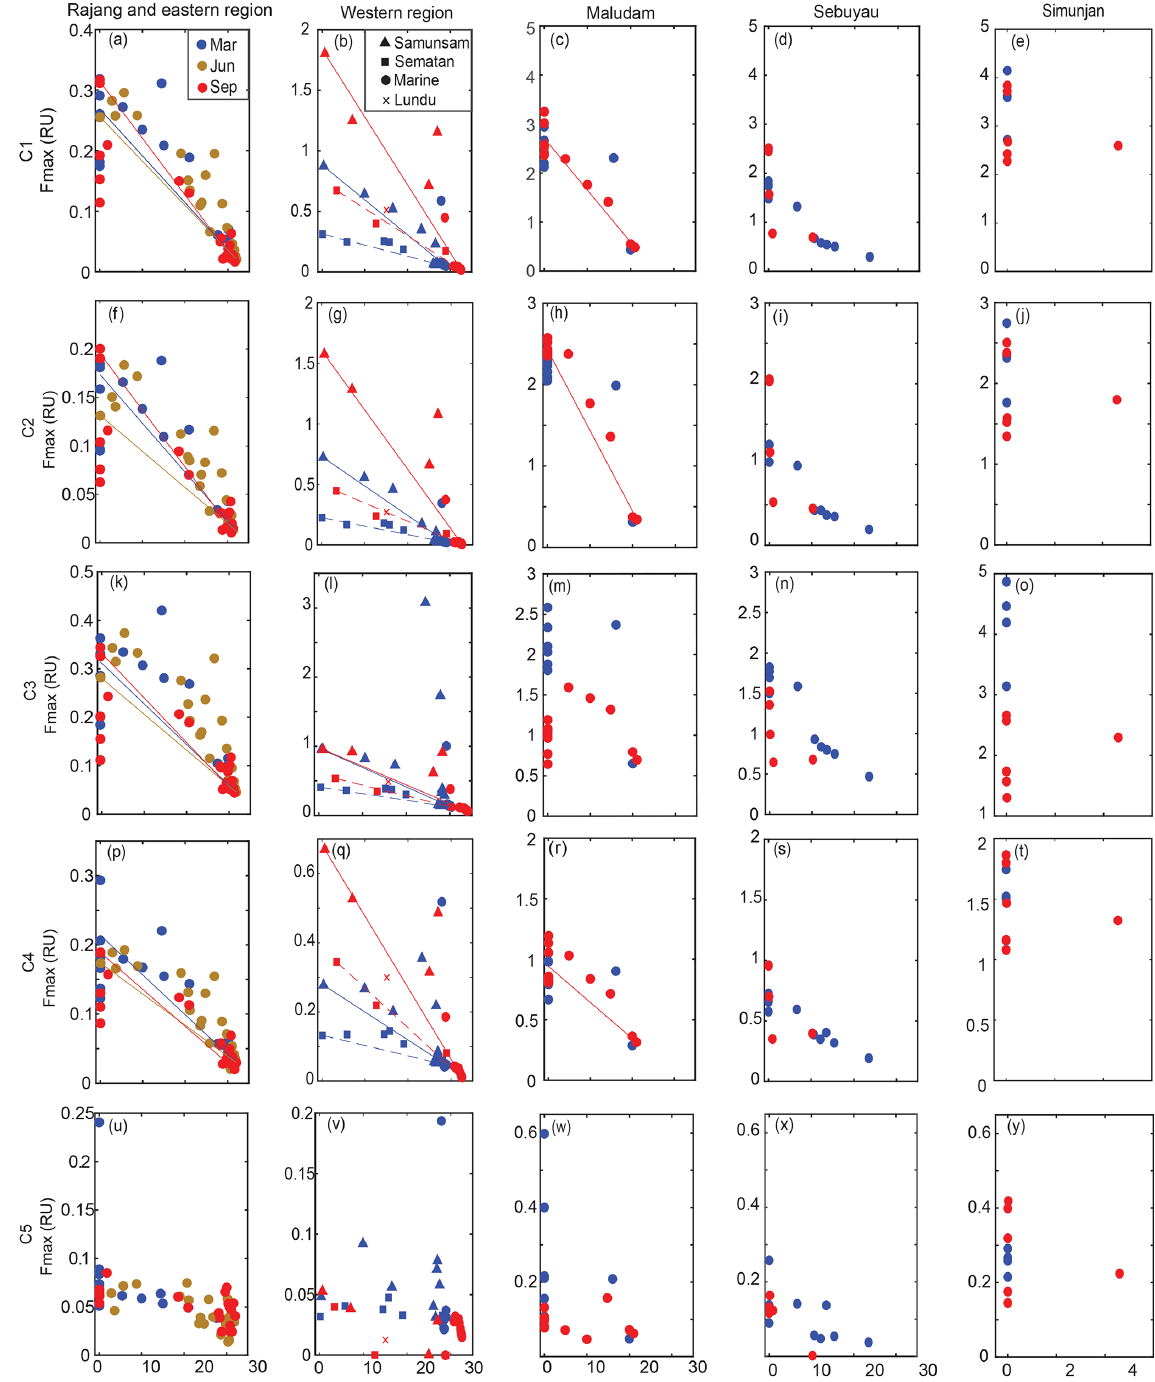
Figure 4. The spatial distribution of C1–C5 Fmax (a–y) for the Rajang and eastern region, the western region, Maludam River, Sebuyau River and Simunjan River. Colors distinguish samples from different seasons in panels (a) – (y) . The conservative mixing models of C1–C4 are delineated for the Rajang and eastern region using solid lines, for Samunsam River using solid lines, for Sematan River using dashed lines and for Maludam River using solid